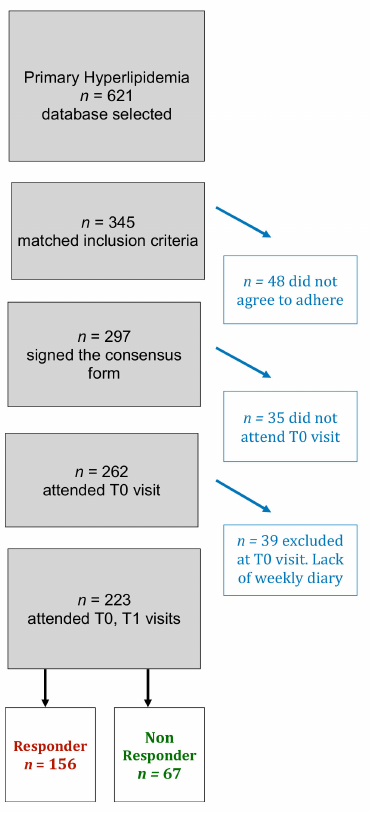
Figure 1. Flow-chart of participants to the